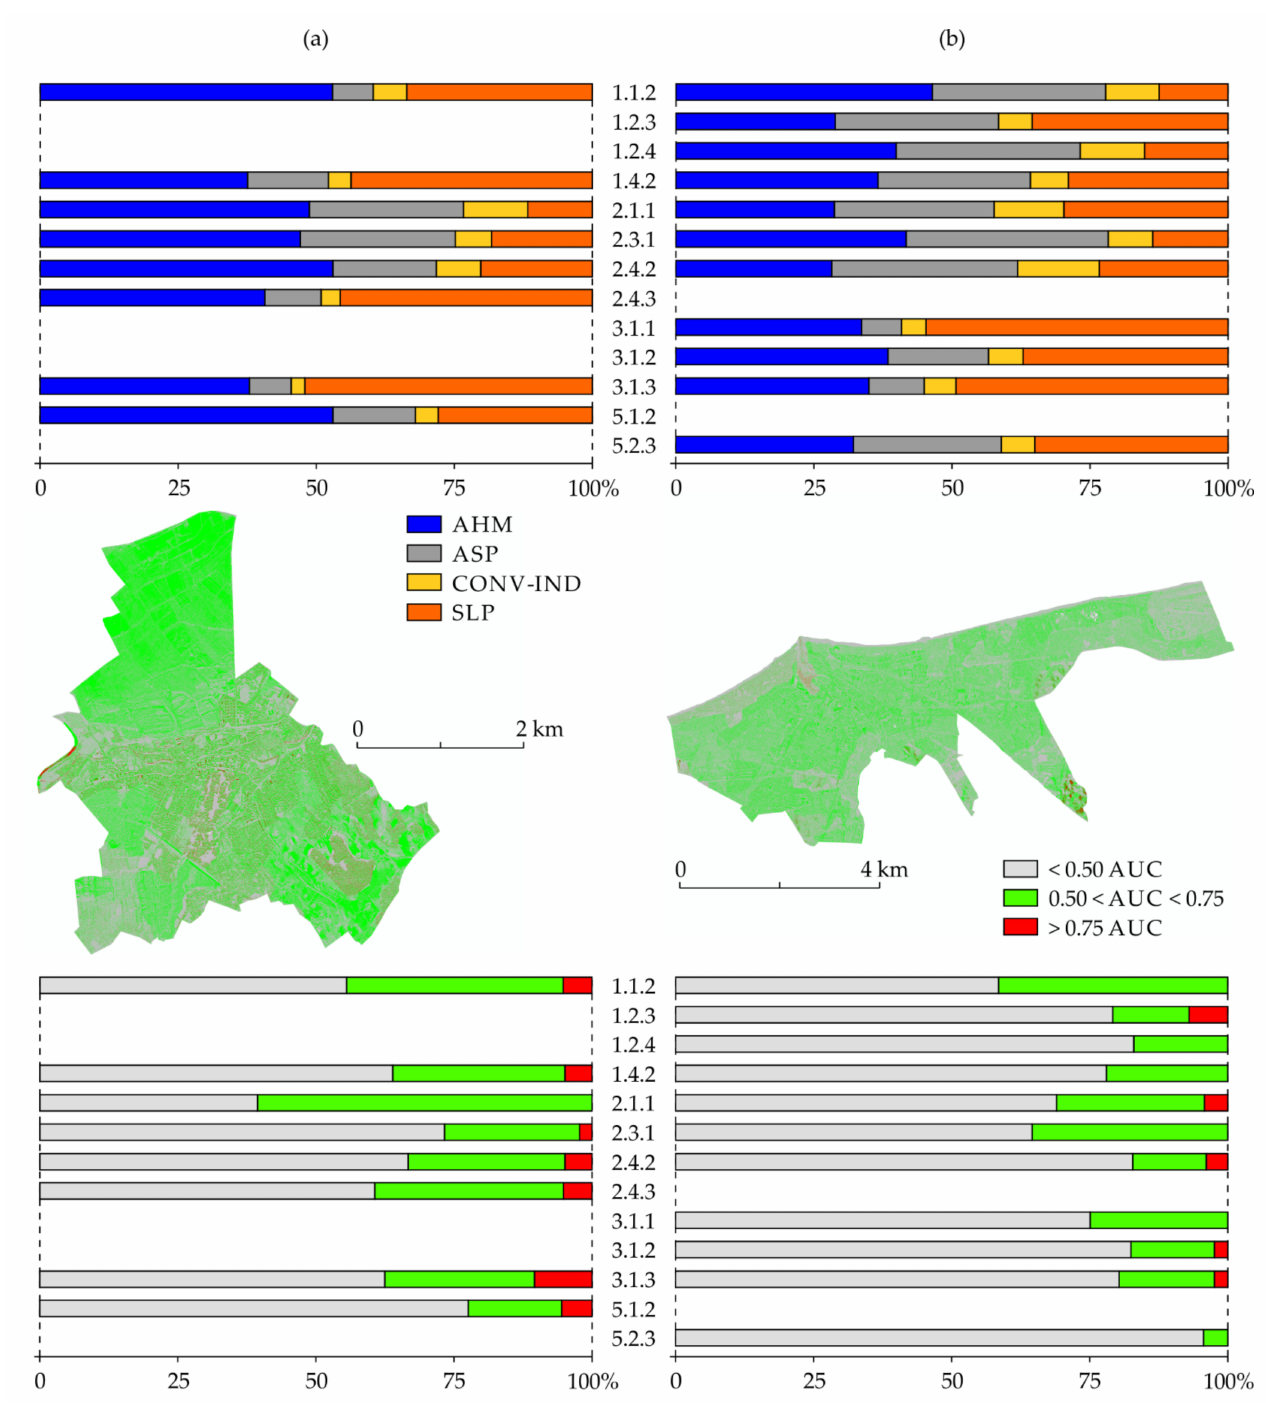
Figure 16. Percentage share in the model of topographic indicators (A) and spatial distribution of AUC values (B) along with the percentage of the area in the given AUC ranges (C) for ( a ) Cieplice and ( b )